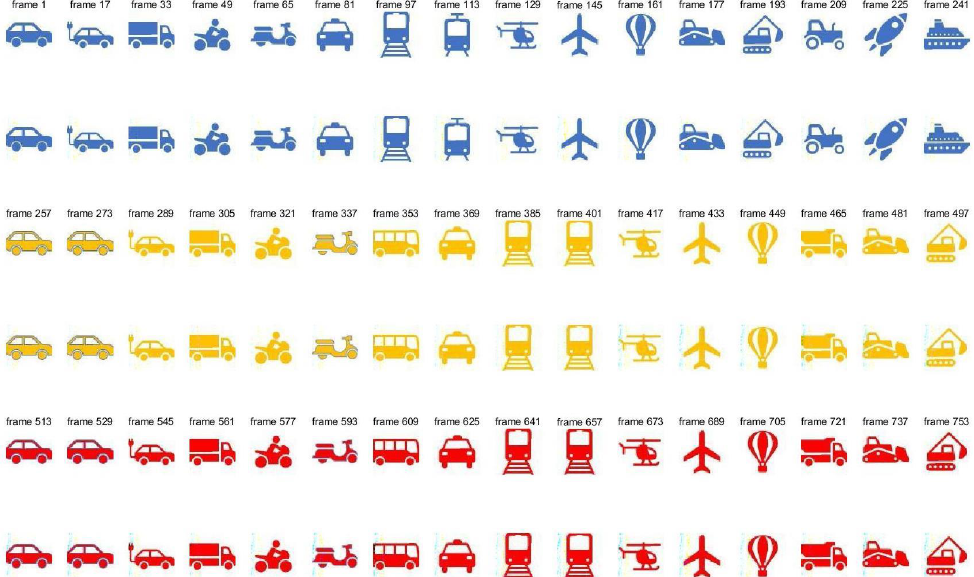
Figure 1. Pictures of original host and watermarked host. Pictures in the first, third, and fifth lines are the frames of the original host video, and pictures in the second, fourth, and sixth lines are the frames of the watermarked